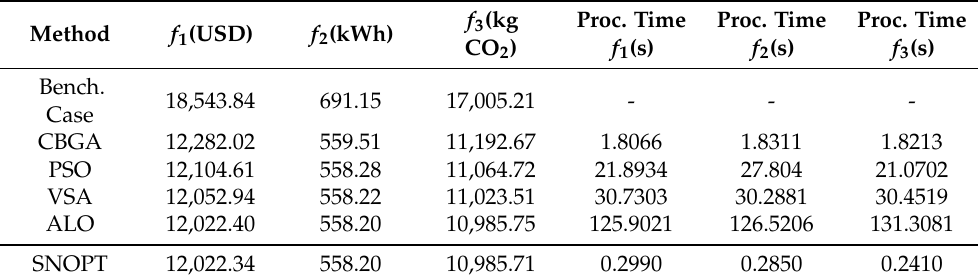
Table 8. Numerical results in the 27-bus system for the rural